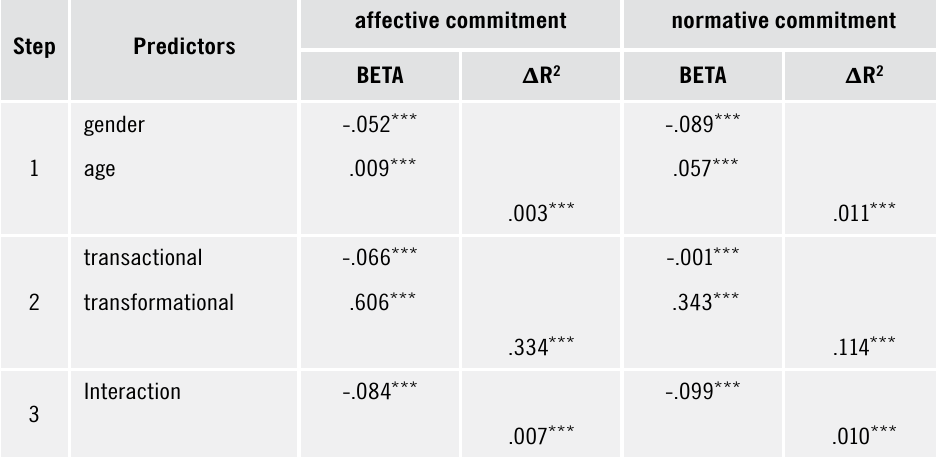
Table 3. Results from hierarchical regression analysis predicting affective and normative